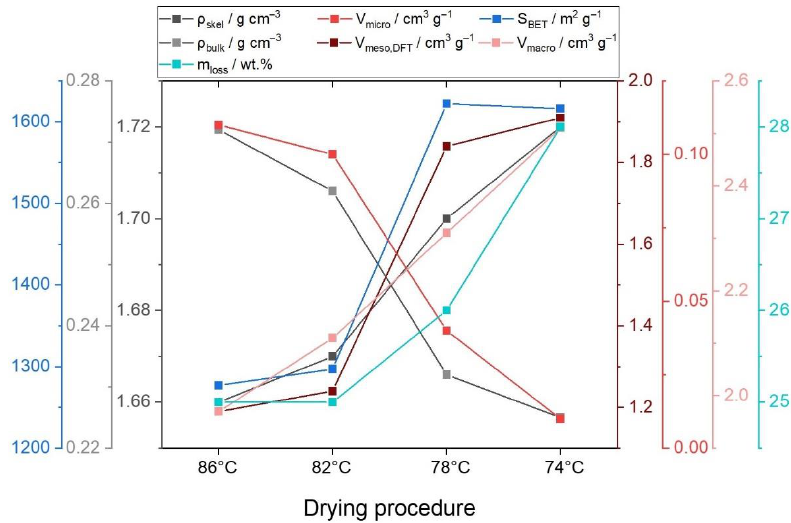
Figure 5. Graphical illustration of the overall trends for the material and textural properties, depending on the evaporative drying temperature.